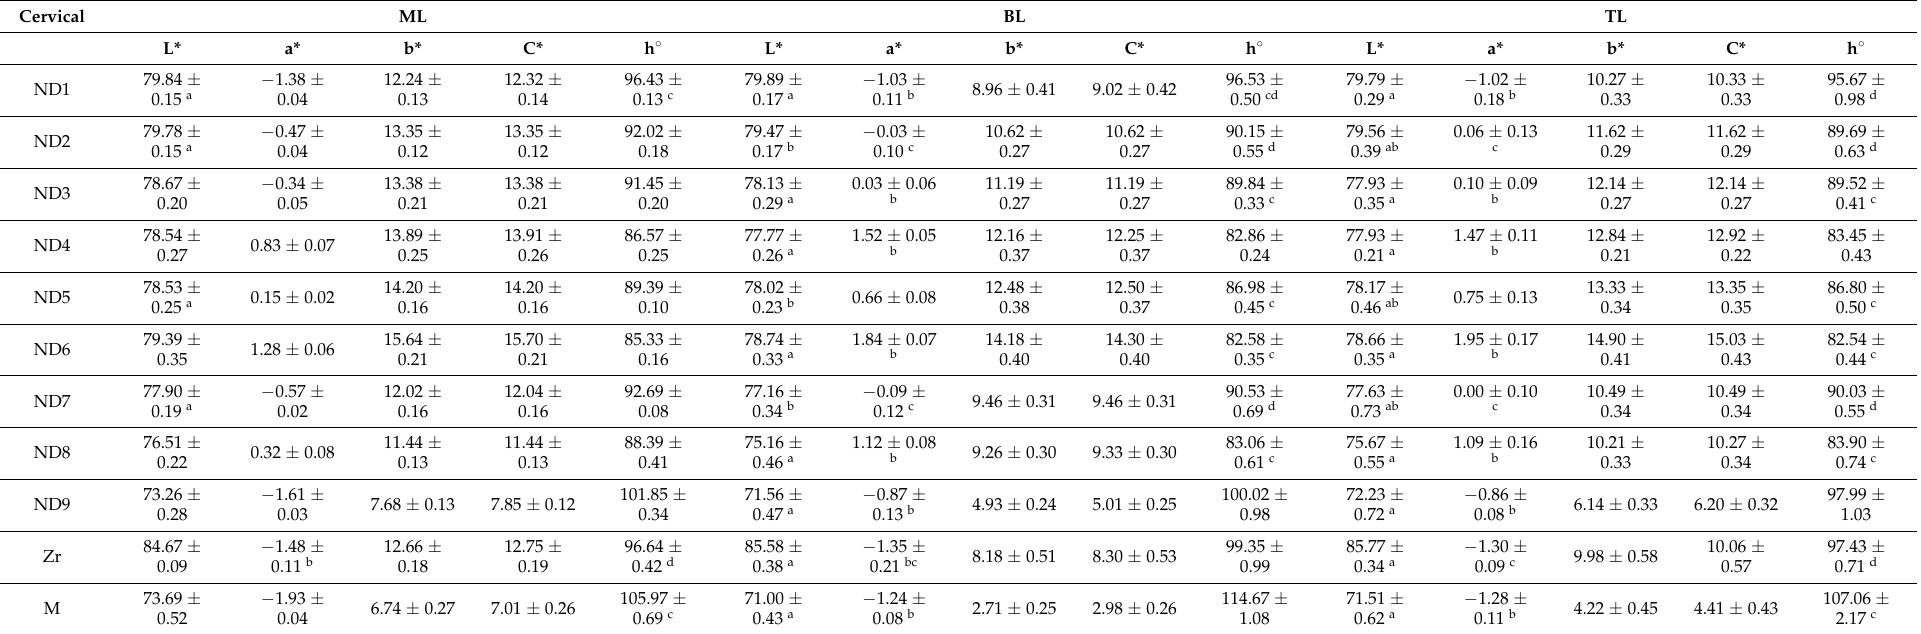
Table 1. Mean values and standard deviation of CIE L*, a*, b*, C*, and h ◦ color coordinates of zirconia crowns on different substrates evaluated for the cervical